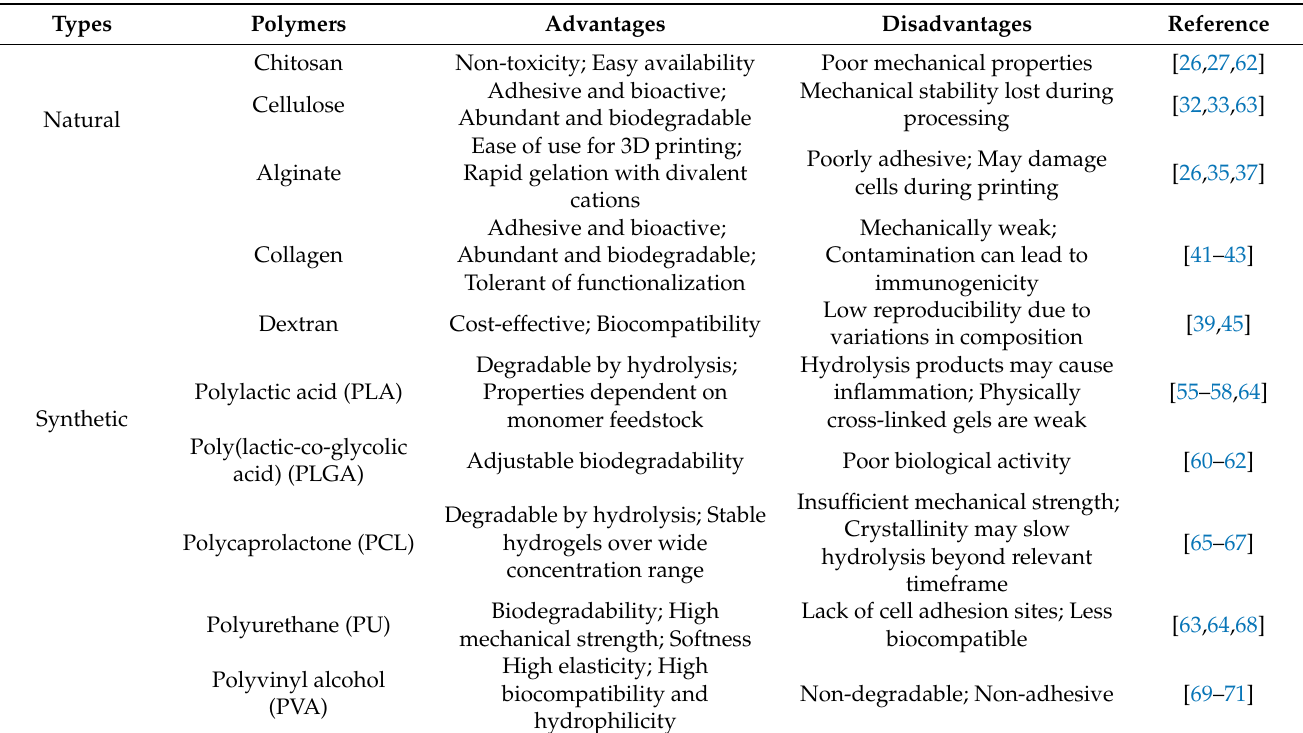
Table 1. Key classes of materials discussed in this review and their key beneficial and detrimen- tal